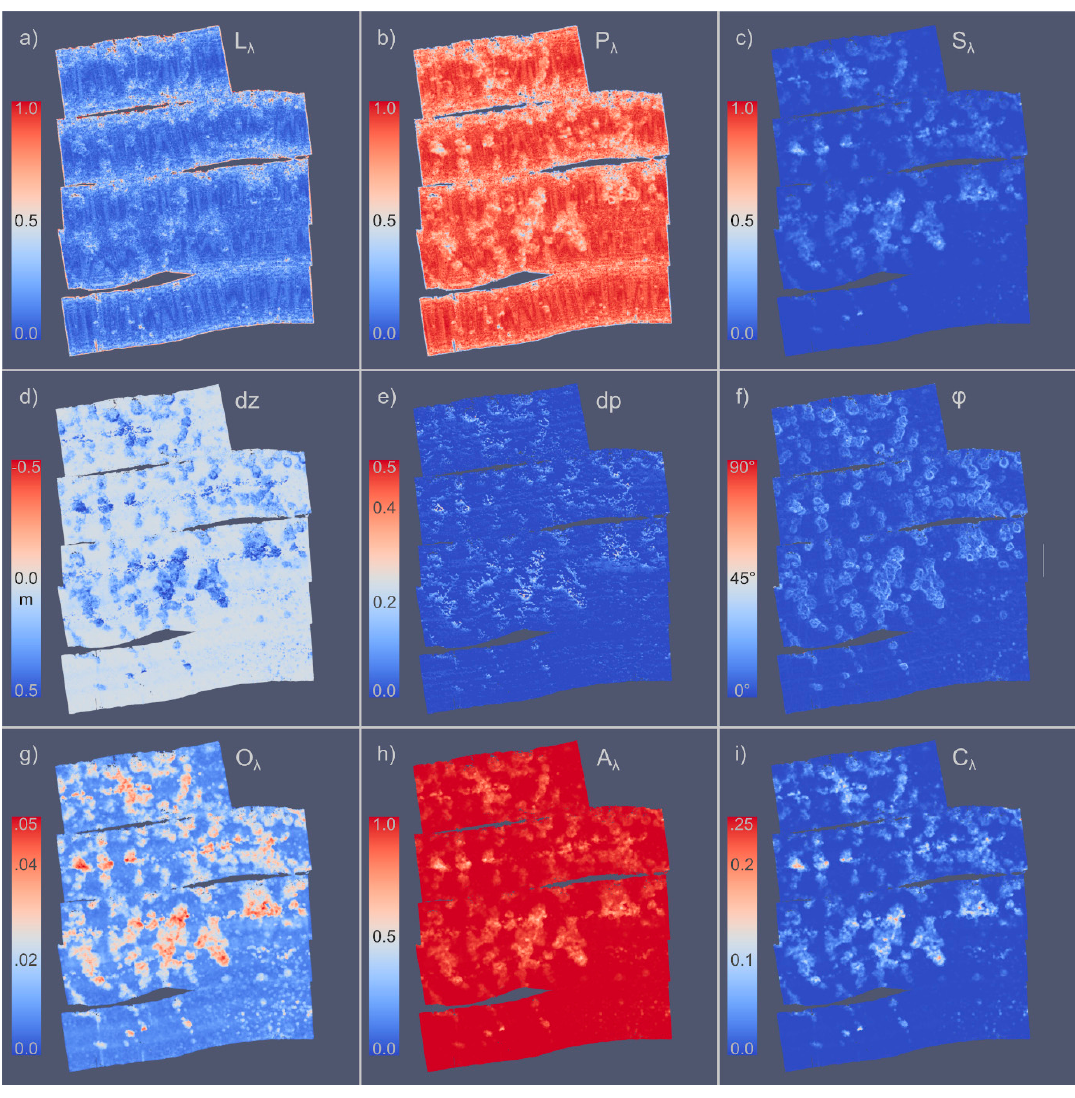
Figure 4. Features computed (equation 3) for all points in SA2: a) Linearity L 𝜆 , b) Planarity P 𝜆 , c) Sphericity S 𝜆 , d) vertical distance between queued point and maximum depth in its neighborhood dz , e) vertical distance between queued point and local plane dp , f) angle between normal of the local plane and vertical φ , g) Omnivariance O 𝜆 , h) Anisotrophy A 𝜆 , and i) change of curvature C 𝜆 . For these computations a cylindrical neighborhood with a radius of 0.5 m was chosen.